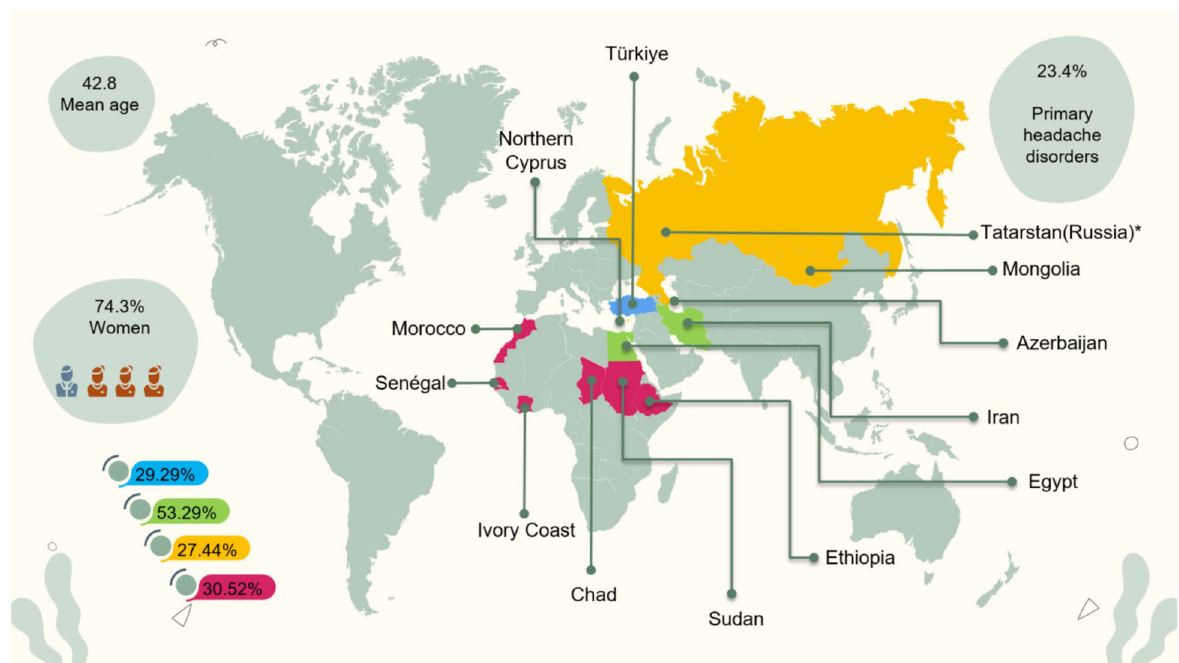
Fig. 1 Prevalences of headaches in the participating Neurology Clinics in the Middle East, Asia, and Africa (at the bottom left corner)